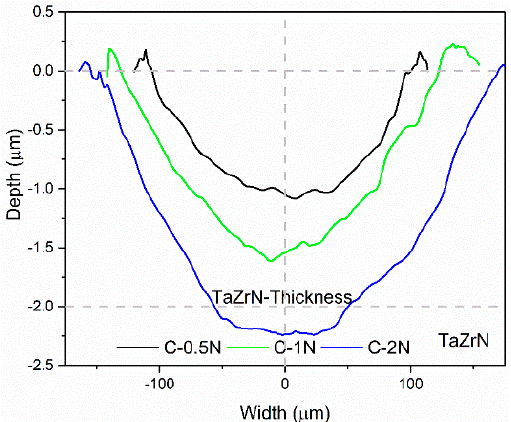
Figure 11. Profiles of wear track on coated surface at 0.5, 1, and 2 N.